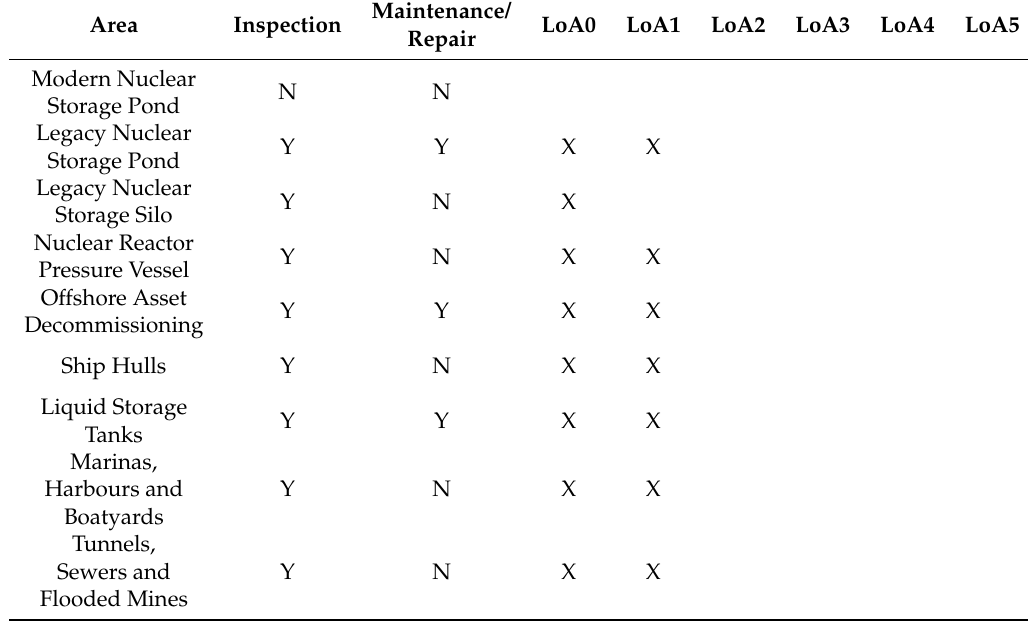
Table 2. Current Mission Types and Levels of Autonomy (LoA) for Different Applications.